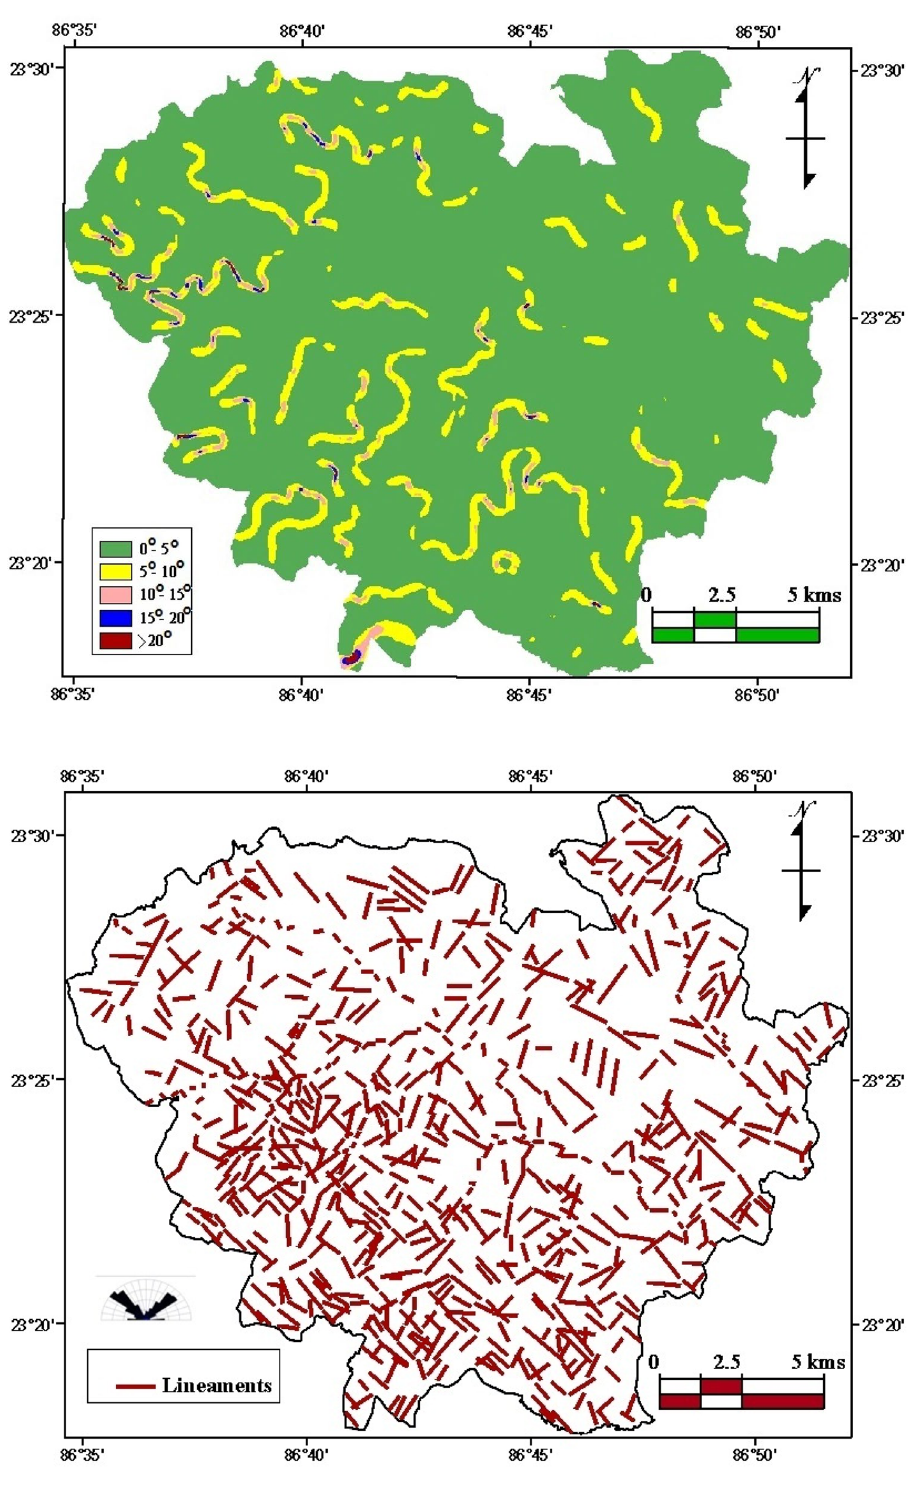
Fig. 6 Slope map of the study area